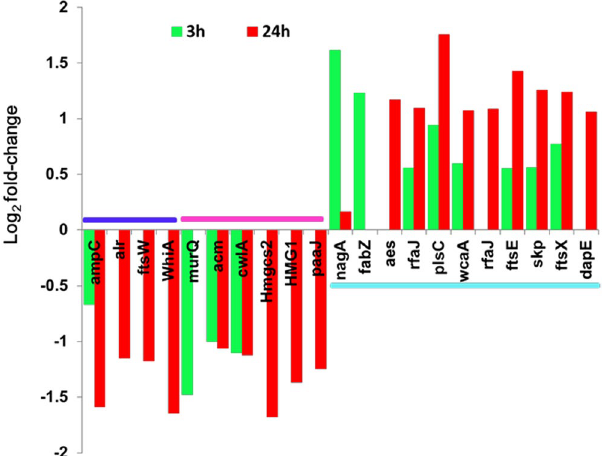
Figure 5. Log 2 fold-change value of genes related to cell division and envelope biogenesis induced by 12%(v/v) ethanol. Color code: blue: cell division, pink: cell wall degradation, cyan: fatty acids or lipid synthesis. 3 h: 3 hours after exposing to ethanol, 24 h: 24 hours after exposing to ethanol.